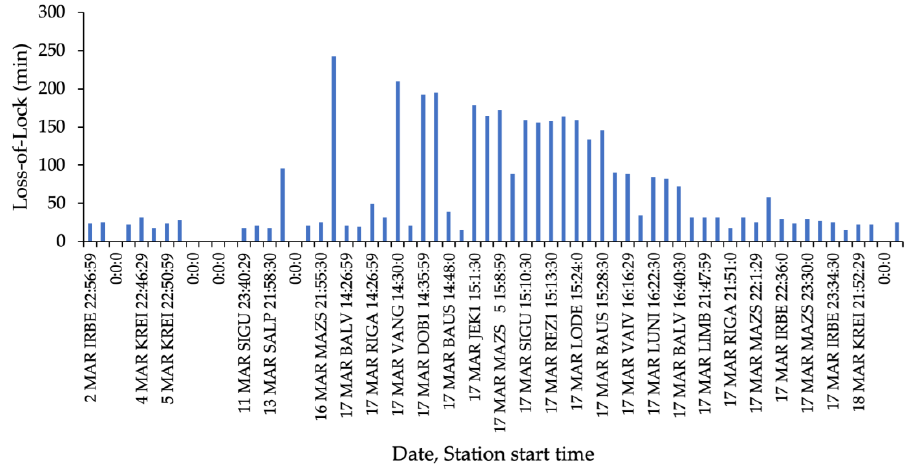
Figure 14. Latvian CORS stations and their respective loss-of-lock start times and durations in minutes (B).